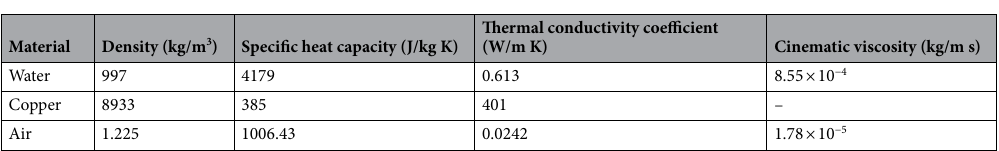
Table 1. Thermophysical properties of materials 26